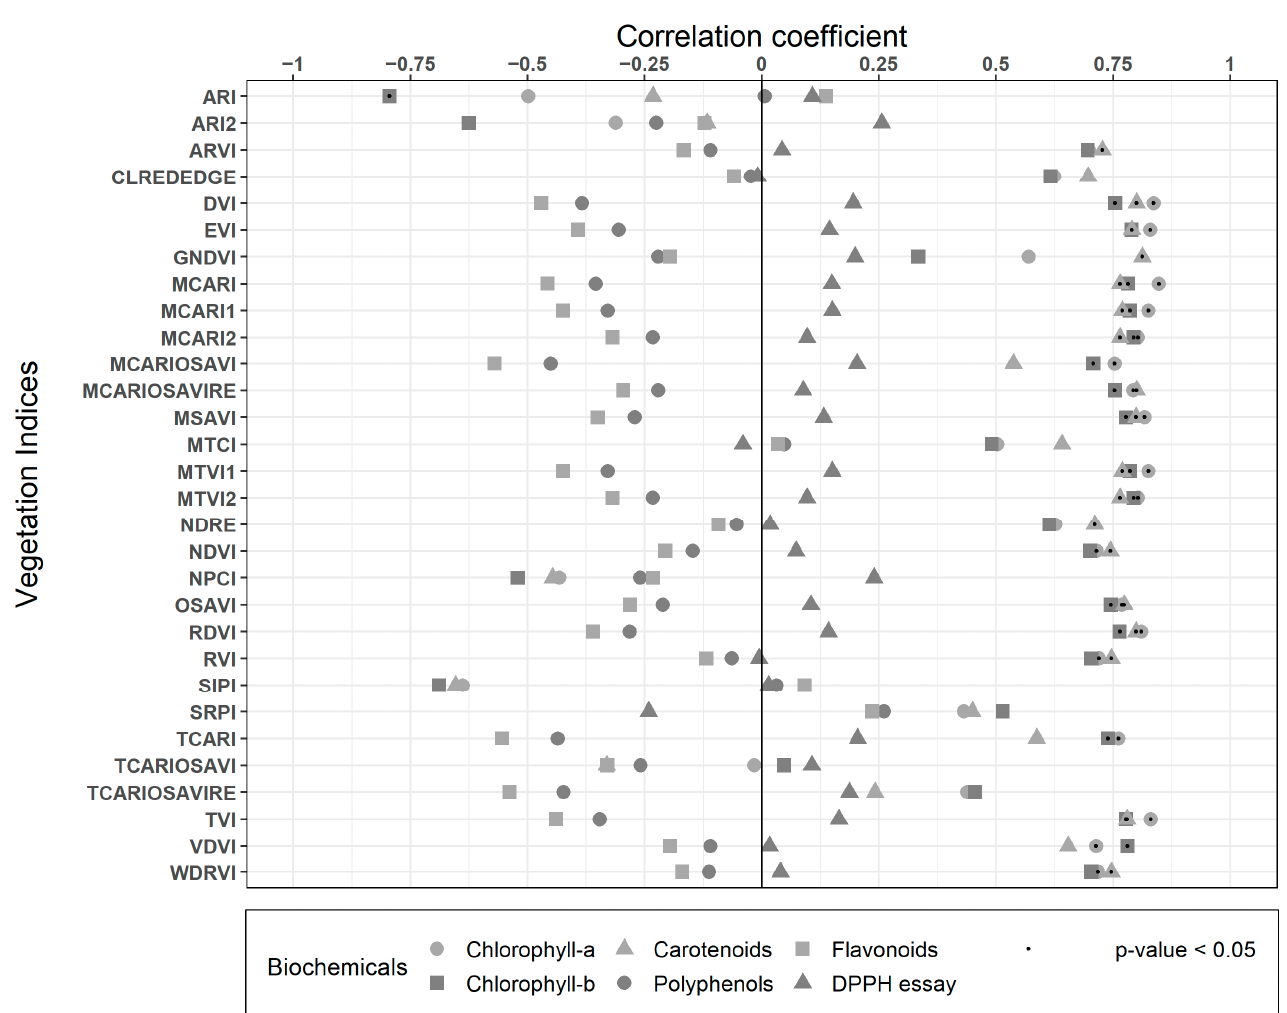
Figure 5. Spearman correlations between the biochemicals traits and the Vegetation Indices (VIs). Vegetation indices with the best significant correlations and biochemical trait represen- tativeness were selected (MTVI1, MCARI, and DVI) and spatialized in Figure 6. All three of them highlight the greenness with higher values, representing a heterogeneous canopy. In the case of MCARI, canopies include the full range of values presented in the scenario, representing a very sensitive index to changes among and within trees, specifically for leaf Chlorophyll concentrations [84]. On the other hand, MTVI1 and DVI show less variation inside canopies, though they differentiate with low and negative values the soil and grass cover. The whole zoomed-in area in Figure 6 (on right) represents a single laboratory value in this work, though single tree canopies present significant variations within the same tree crown. The spatial resolution of the imagery allows the forest to be analyzed at nearly leaf level, and therefore more detail and variations can be considered in further studies (i.e., separating each tree crown by exposition or radio segments from the center).